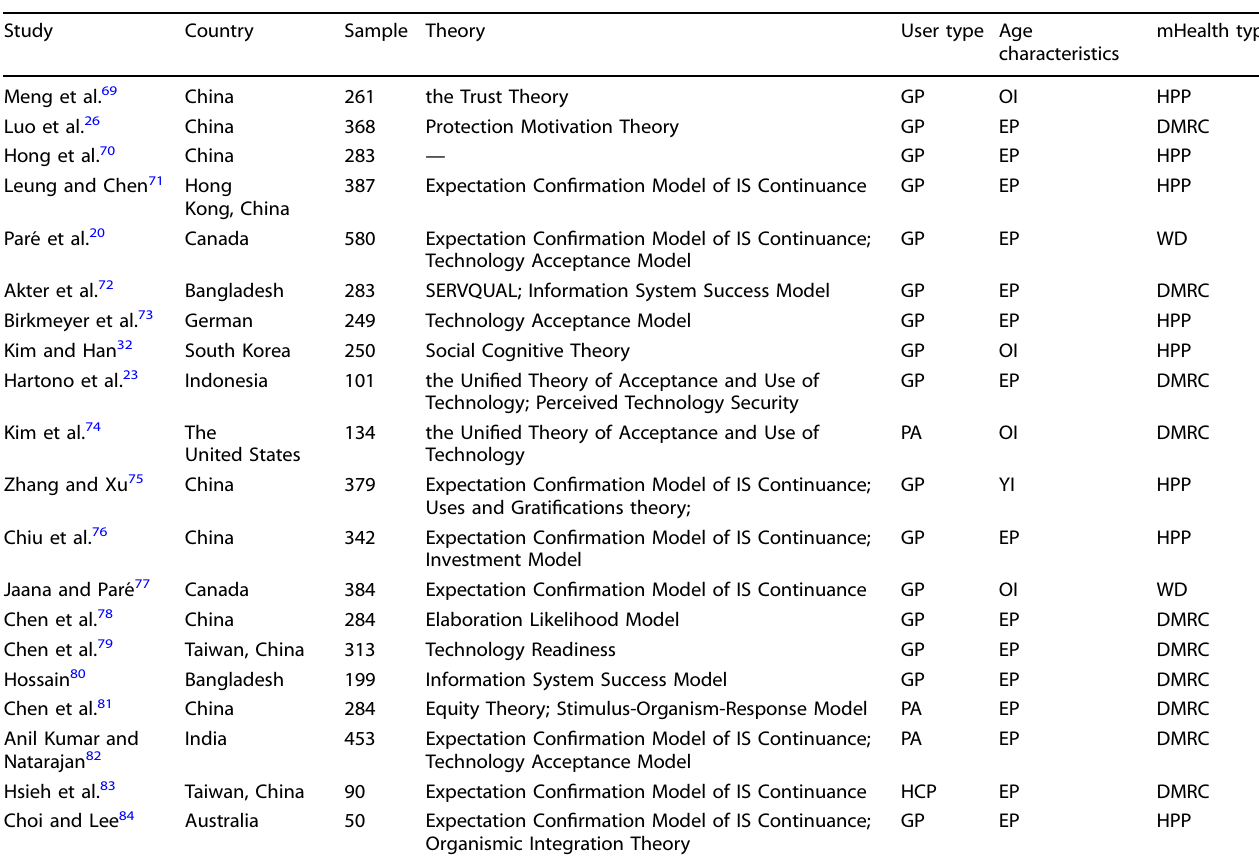
Table 1. The three countries which were the most highly active in research were China (25 studies), South Korea (7 studies) and the United States (6 studies). The most frequently used theories and models were the Expectation Con fi rmation Model of IS Con- tinuance (ECM-ISC, 15 times), Technology Acceptance Model (TAM, 9 times) and the Uni fi ed Theory of Acceptance and Use of Technology (UTAUT, 6 times). All studies used